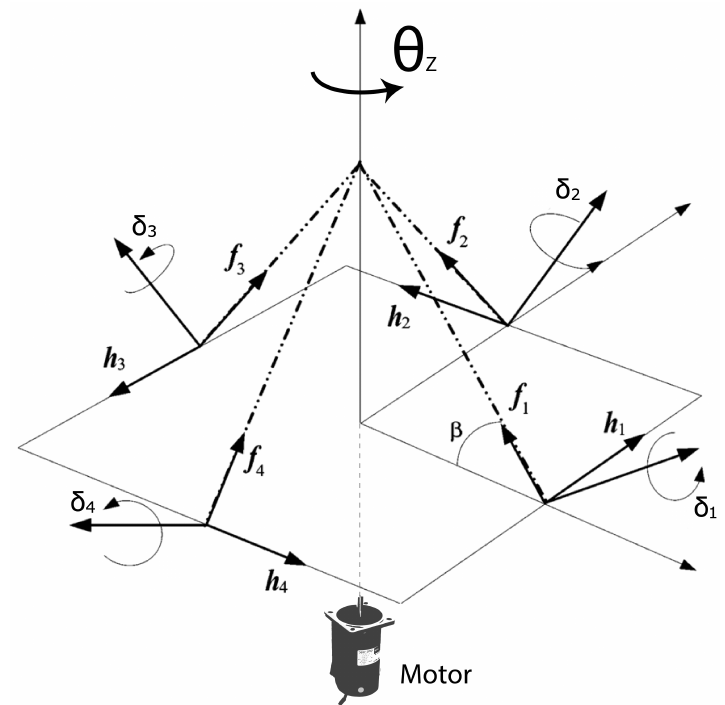
Figure 1. Gimballed control moment gyroscope (GCMG) visualization